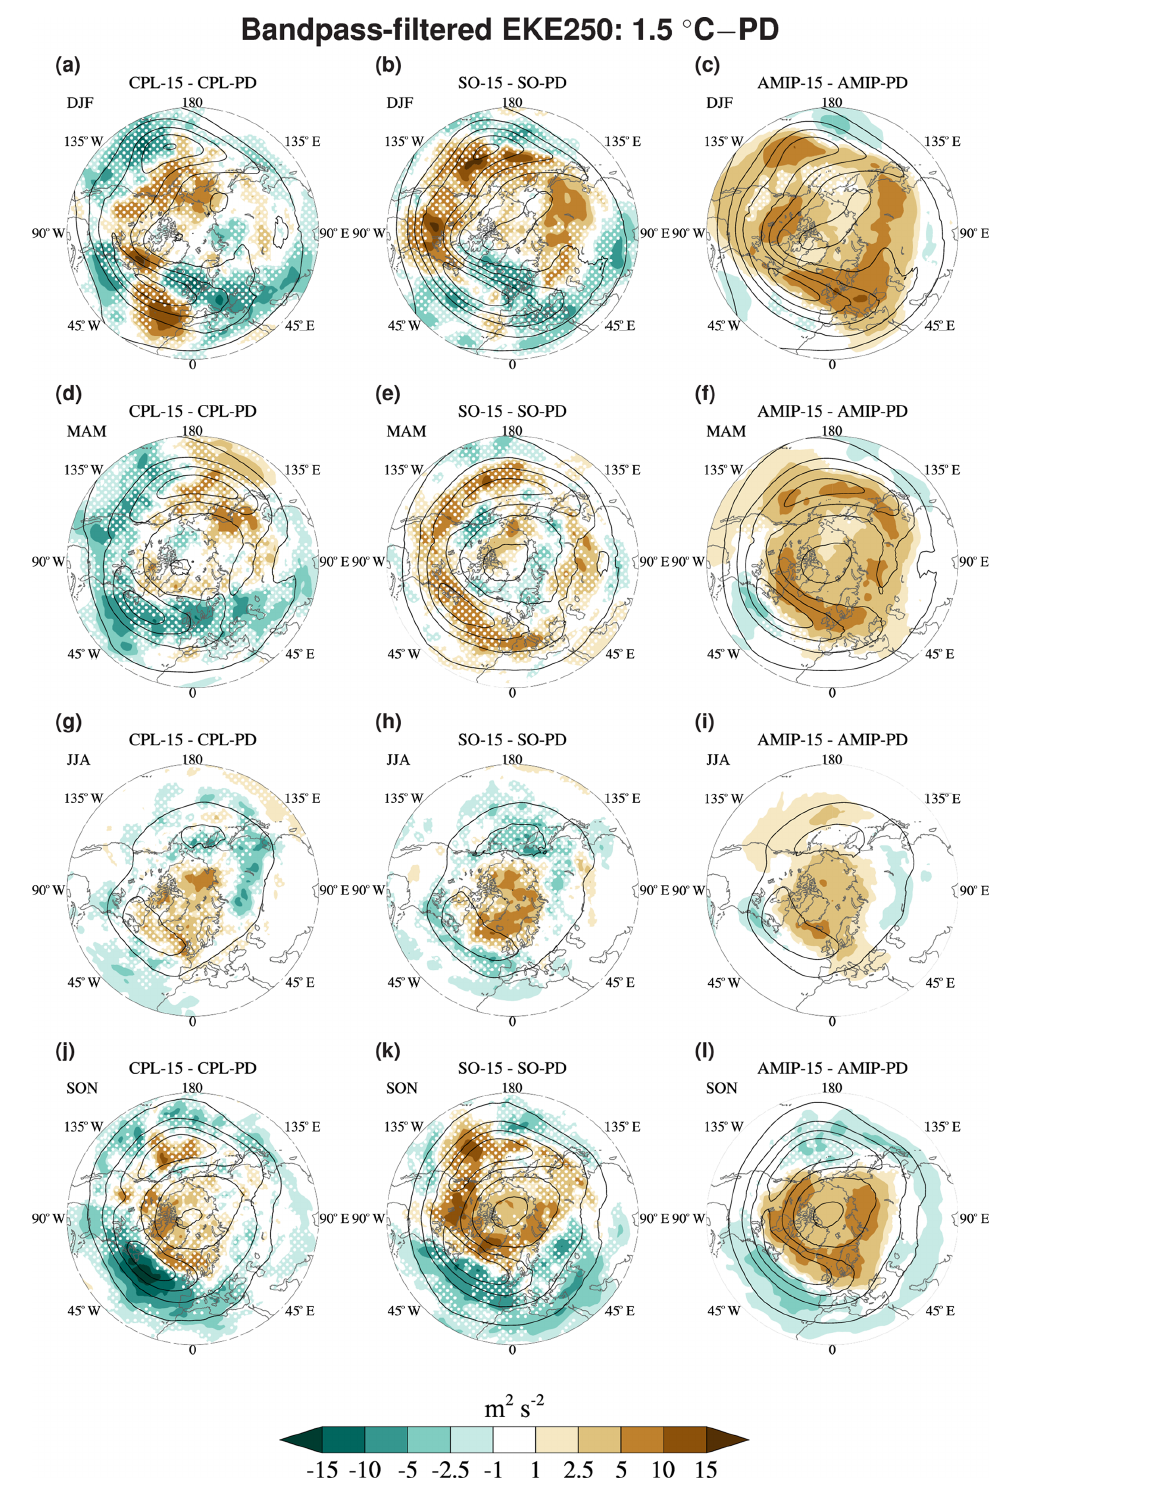
Figure 13. Changes in upper-level storm-track activity relative to PD (colours) and climatology (black contours; 40 to 240m 2 s − 2 in increments of 40m 2 s − 2 ) for the 1.5 ◦ C experiment from NorESM1-Happi (a, d, g, j) , NorESM1-HappiSO (b, e, h, k) , and NorESM1- HappiAMIP (e, f, i, l) for DJF (a–c) , MAM (d–f) , JJA (g–i) , and SON (j–l) . The storm tracks are represented in terms of bandpass-filtered EKE (eddy kinetic energy) at 250hPa. The white dots indicate that the differences are not significant at the 5% level according to the Welch t test. The fields are shown for the default periods given in Sect. 3. Units are in m 2 s − 2 (a–l) .